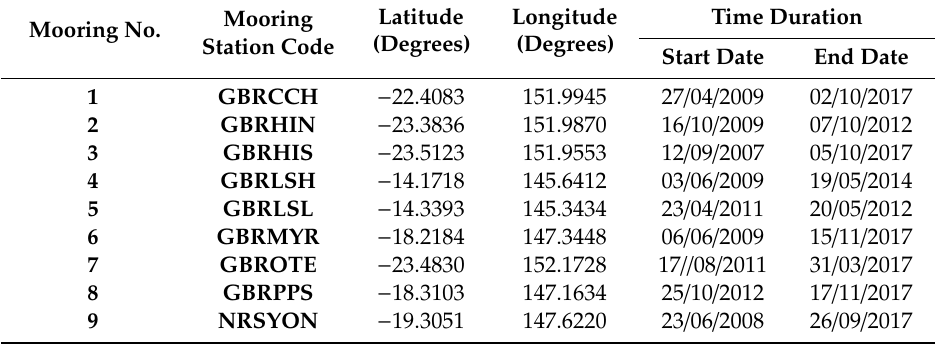
Table 3. The geographic position and period of observation records for mooring stations. Mooring No.